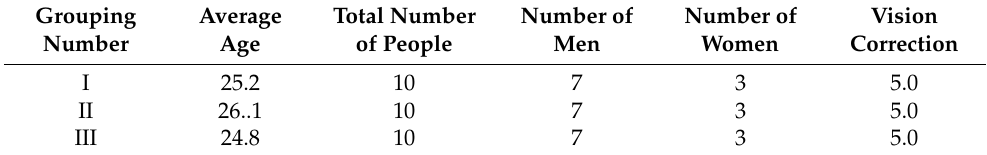
Table 6. Testing personnel information.